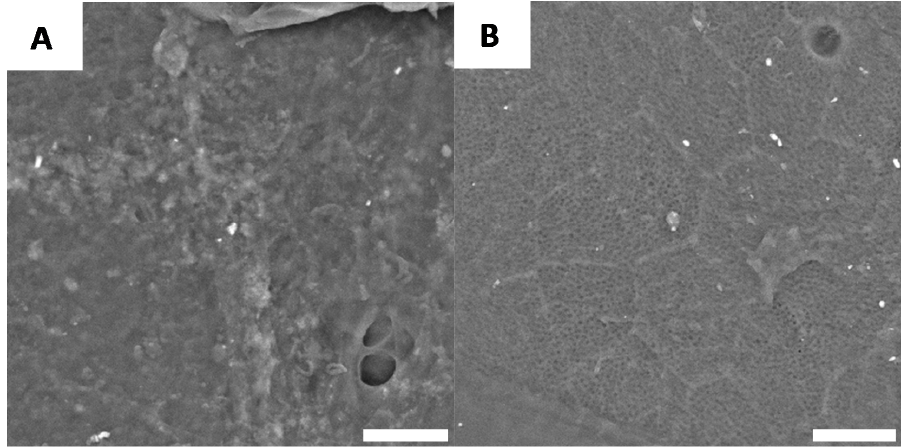
Figure 6. Examples of morphology observed for G. orientalis after deproteination (Scale bar = 10 µm). ( A ) Example of observed irregular morphology; ( B ) Example of chitin network.